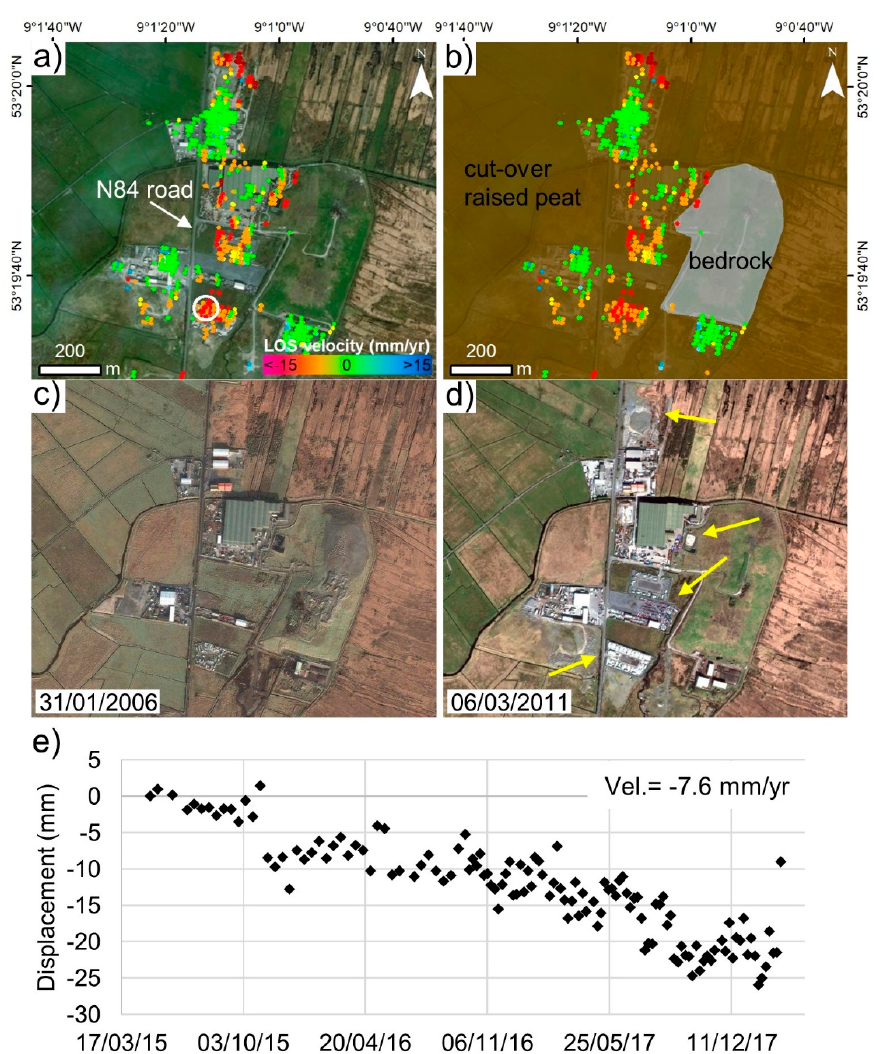
Figure 10. ( a ) Surface movements occurring in a suburban area north of Galway city, denoted locality ‘b’ in Figure 7. ( b ) Map of Pleistocene-Holocene superficial deposits and bedrock outcrop; the colors correspond to the legend in Figure 4b. ( c and d ) Google Earth images showing the urban development of the area (yellow arrows) as occurred between 2006 and 2011. ( e ) Displacement time series for the location marked by the white circle in ( a ).